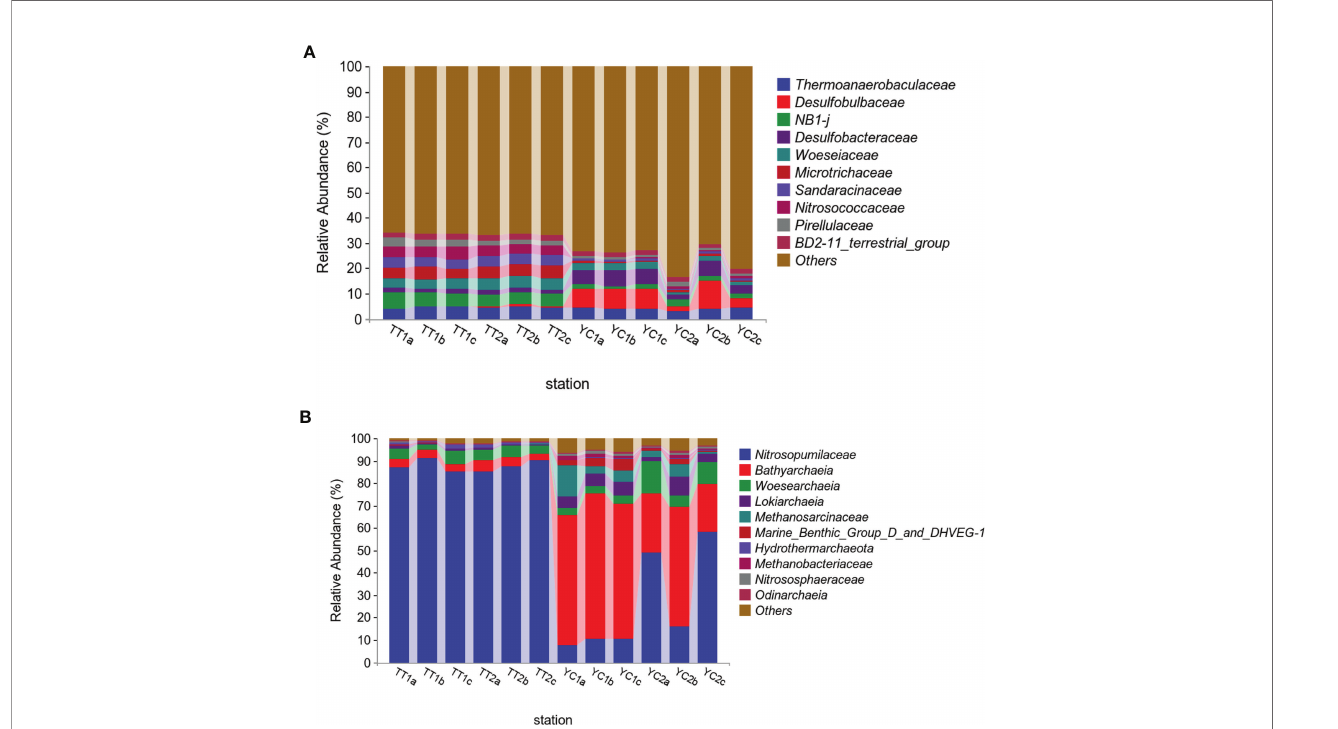
FIGURE 2 | The bacteria (A) and archaea (B) assemblage composition on family level, threshold for showing the family names is top 10% in OTUs. Photo by Z-Y